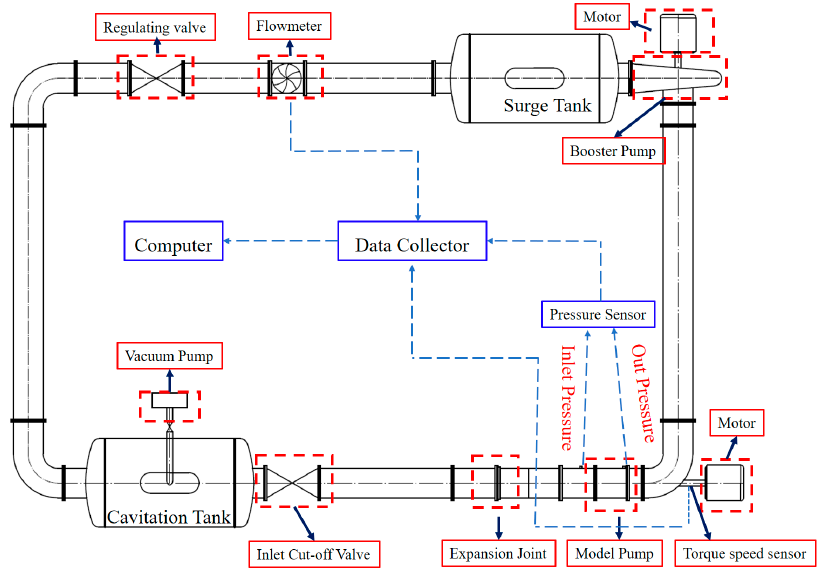
Figure 7. Schematic map of the hydraulic test rig.